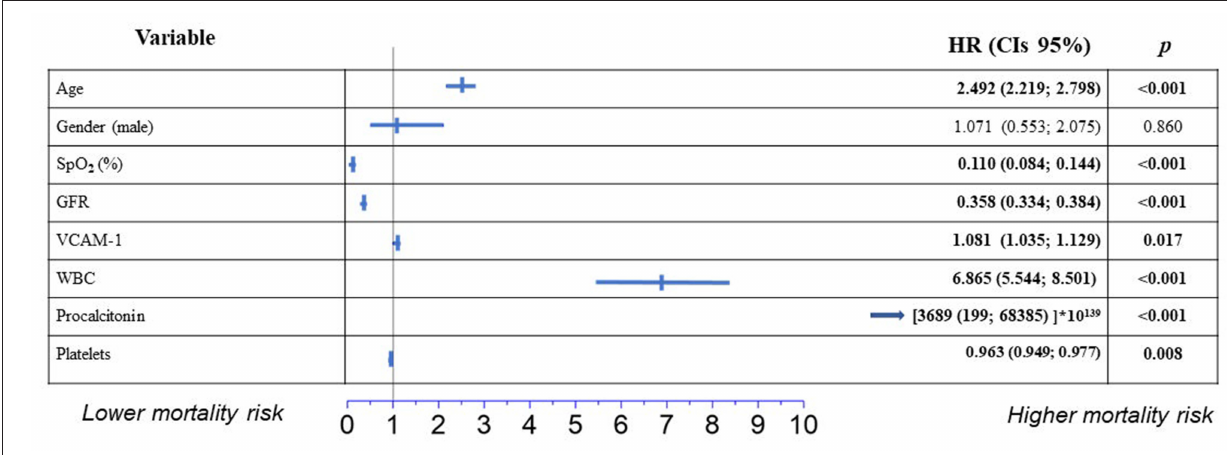
FIGURE 3 | Independent predictors of hospital mortality from COVID-19 in multivariable survival regression (Bayesian Hierarchical Cox model) in a multi-marker model. Results are reported as hazard ratio (HR) and 95% confidence intervals